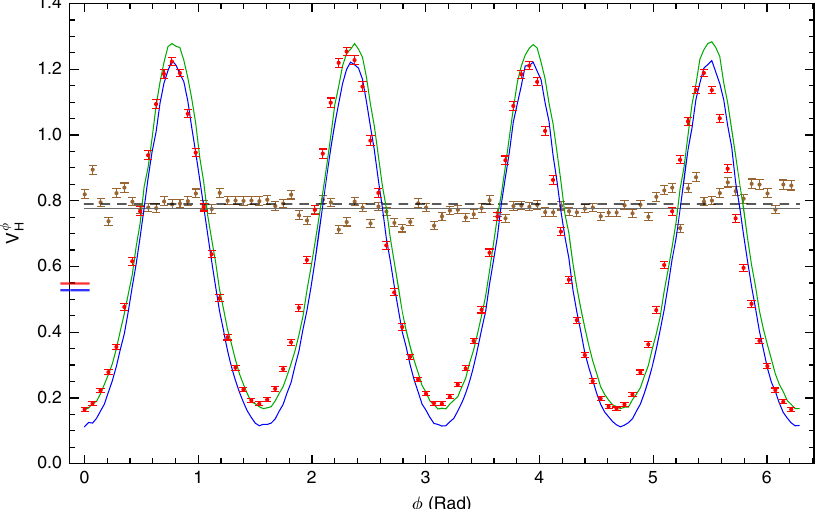
as a function of ϕ . The red Fig. 4 Heisenberg-limited phase estimation with N = 3 resources. Red dots represent experimentally measured variance V ϕ H horizontal line-segment cutting the left axis shows the optimal protocol Holevo variance V 0 : 5497 ± 0 : 0007, determined from these data, while blue H ¼ line-segment shows the HL. The blue and the green curves represent results of numerical simulations of the variance for the ideal optimal state ρ and opt experimentally prepared state ρ , respectively. Brown dots represent V ϕ for the shot-noise-limited interferometry and the black dashed line represents H exp the measured Holevo variance V 0 : 7870 ± 0 : 0007 for the same measurement. The grey solid line shows the SNL. Numerical values for the H ¼ experimental results and corresponding limits are detailed in Table 2. Each data point was calculated from at least 50,000 twofold coincidence events and the error bars represent 95% con fi dence intervals calculated with the bootstrap method 23